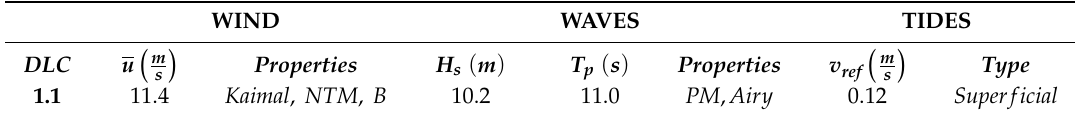
Table 2. Wind, wave and tide conditions considered for the monopile evaluation.